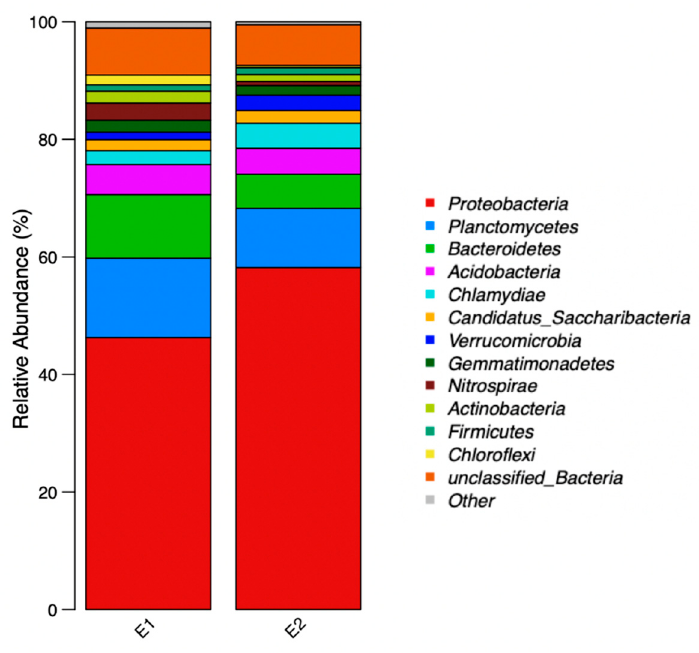
Figure 9. Microbial relative abundance on substrates at the phylum level.